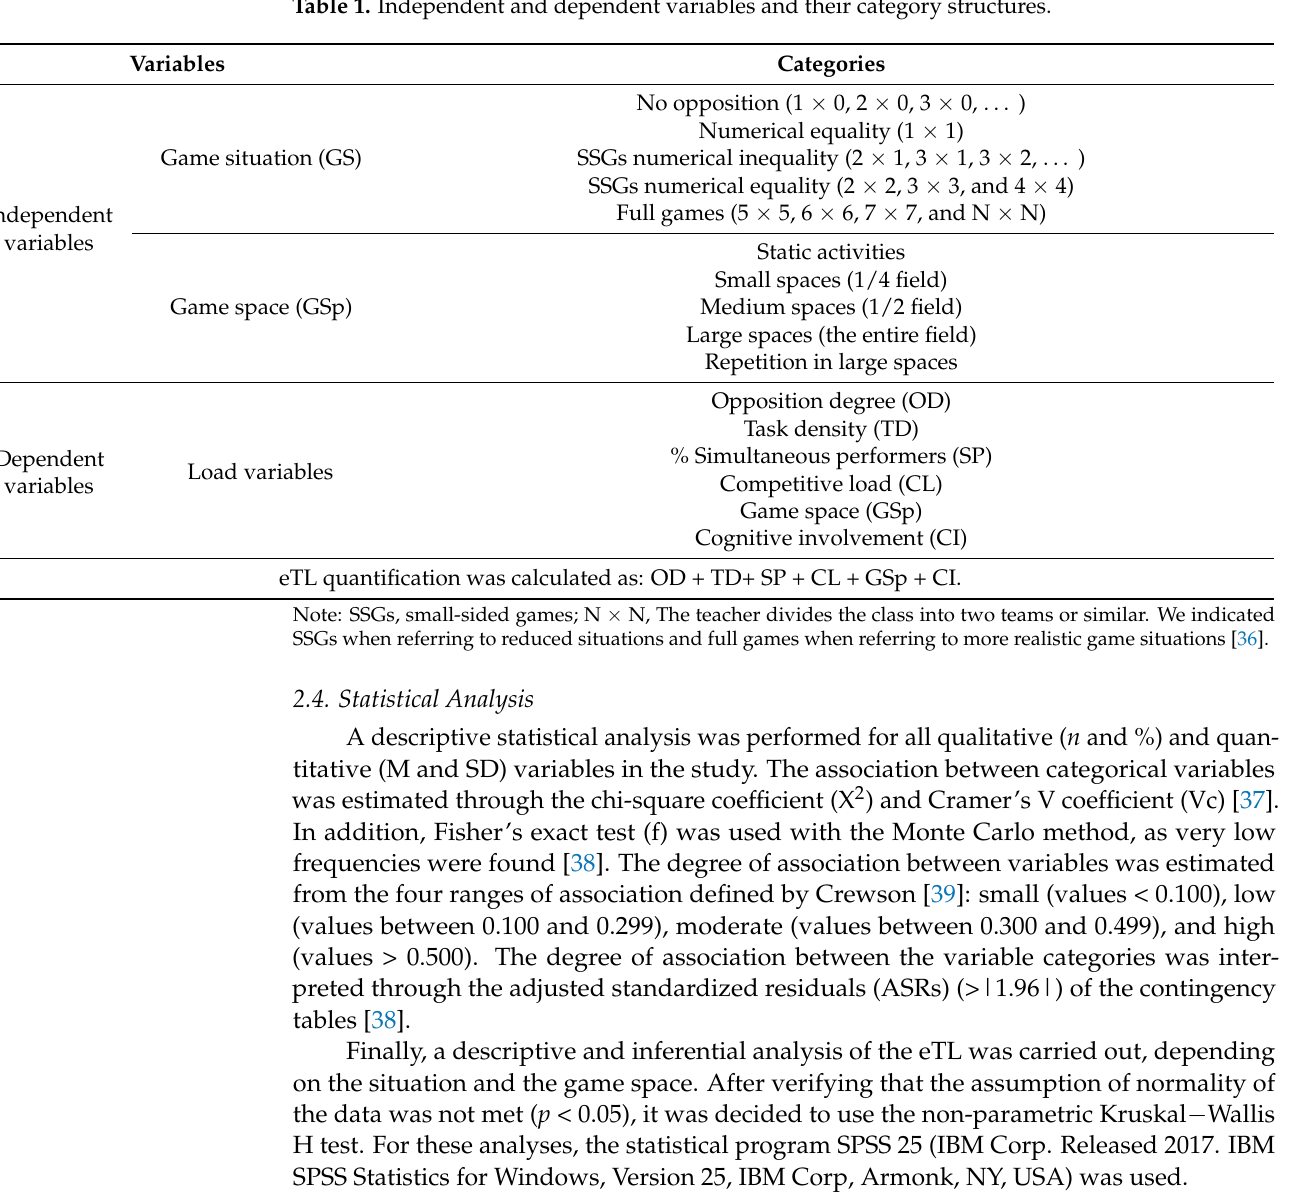
Table 1. Independent and dependent variables and their category